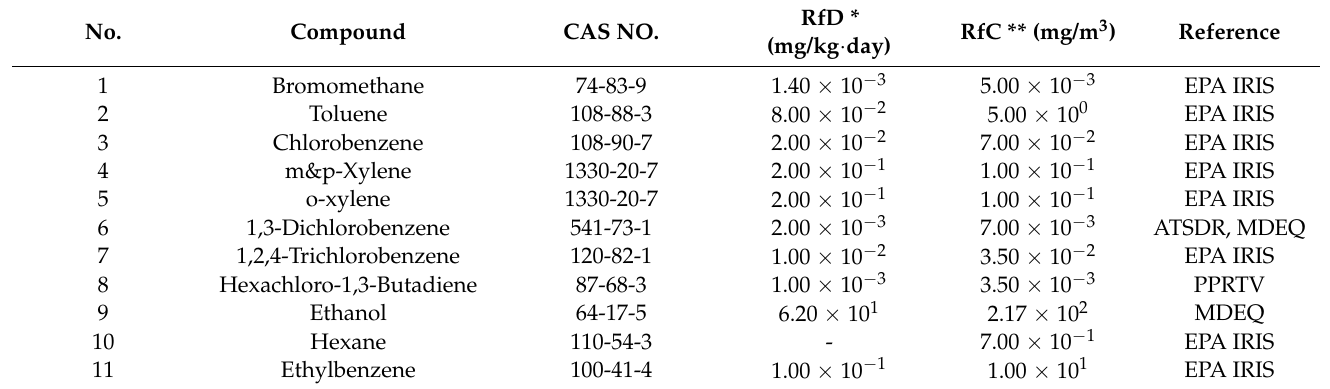
Table 2. Dose–response data of toxic non-carcinogenic